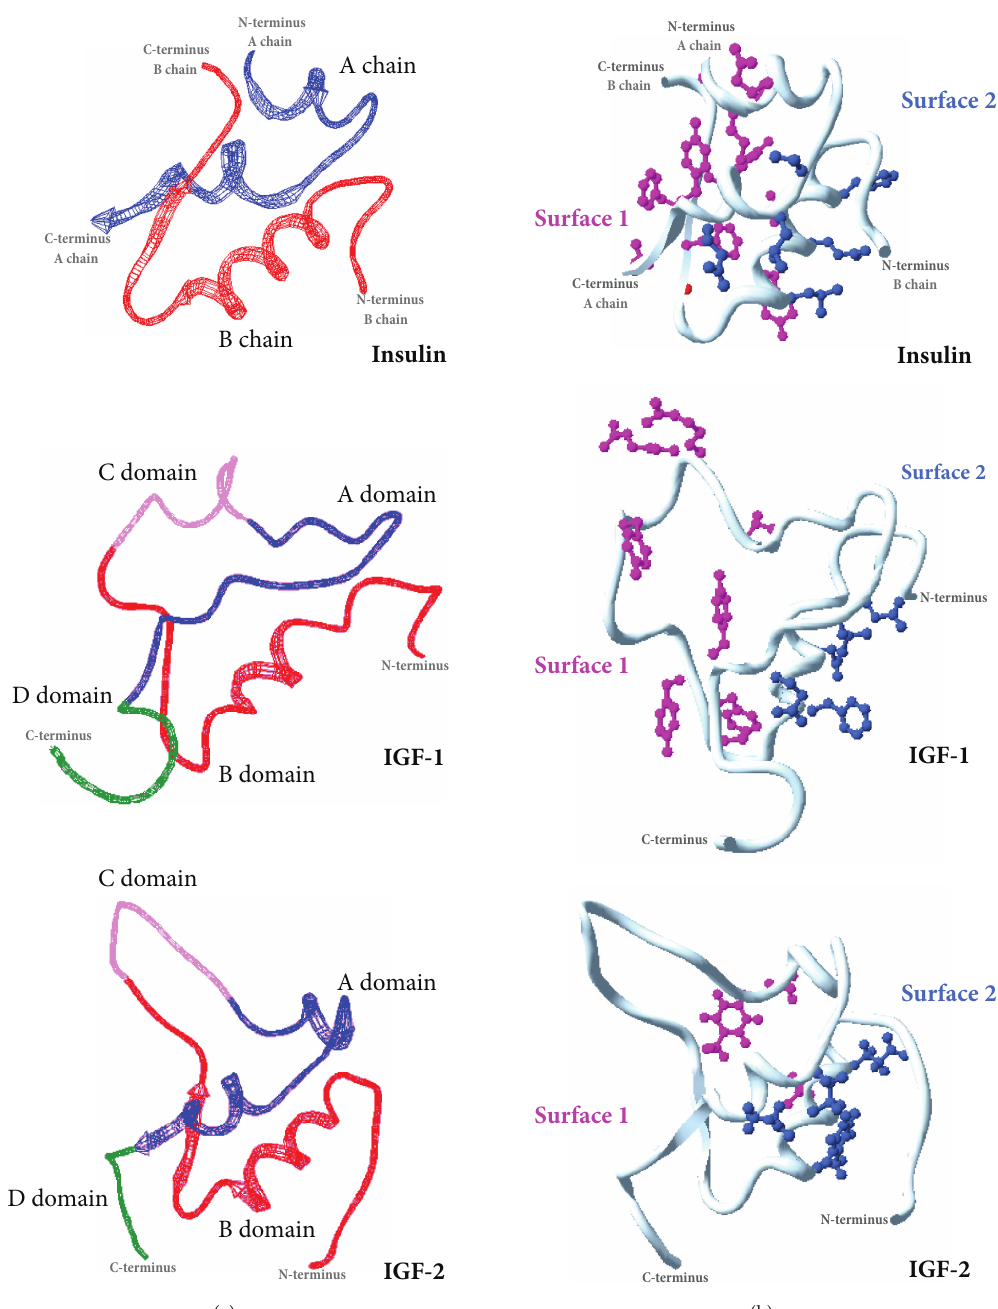
Figure 5: Representation of the three-dimensional structures of insulin, IGF-1, and IGF-2, and of the two binding surfaces on the ligands. Ribbon representations of the three-dimensional structures of the three ligands are shown with the insulin B chain and equivalent B domains of IGF-1 and IGF-2 coloured in red, the C domains of IGF-1 and IGF-2 in pink, the insulin A chain and A domains of IGF-1 and IGF-2 in blue, and the D domains of IGF-1 and IGF-2 in green (a). The three insulin 𝛼 helices, one in the B chain and two in the A chain, are visible as are the equivalent structures in IGF-1 and IGF-2. The positions and orientations of the side chains of the residues implicated in interaction of the ligands with the receptors are shown on the backbone of the molecule structures which are coloured in grey (b). The side chains are shown in ball-and-stick view. The side chains of the residues located on binding Surface 1 are coloured in pink and those located on binding Surface 2 are coloured in blue. Residues ValB12, TyrB16, GlyB23, PheB24, PheB25, TyrB26, GlyA1, IleA2, ValA3, GlnA5, TyrA19, and AsnA21 of insulin are involved in Surface 1 and HisB10, GluB13, LeuB17, SerA12, LeuA13, and GluA17 in Surface 2. For IGF-1, residues Phe23, Tyr24, Tyr31, Arg36, Arg37, Val44, Tyr60, and Ala62 form Surface 1 and residues Glu9, Asp12, Phe16, Leu54, and Glu58 are thought to contribute to Surface 2. In IGF-2, residues Val14, Phe28, and Val43 are included in Surface 1 and residues Glu12, Phe19, Leu53, and Glu57 in Surface